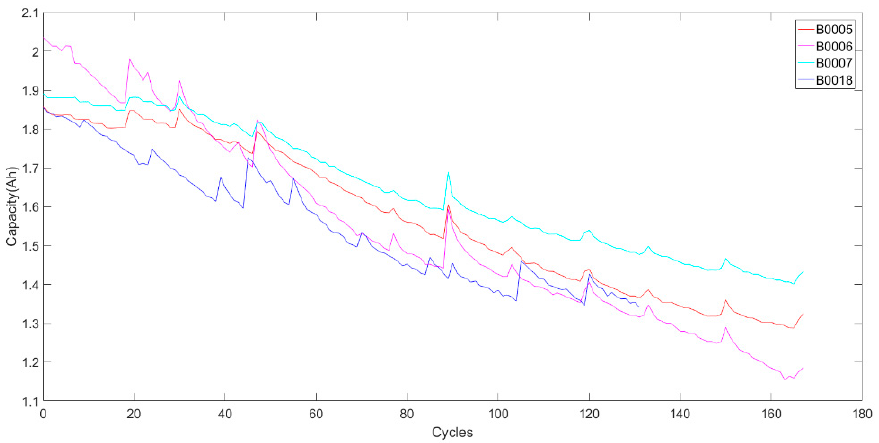
Figure 3. Capacity fade curves of B0005, B0006, B0007, and B0018.